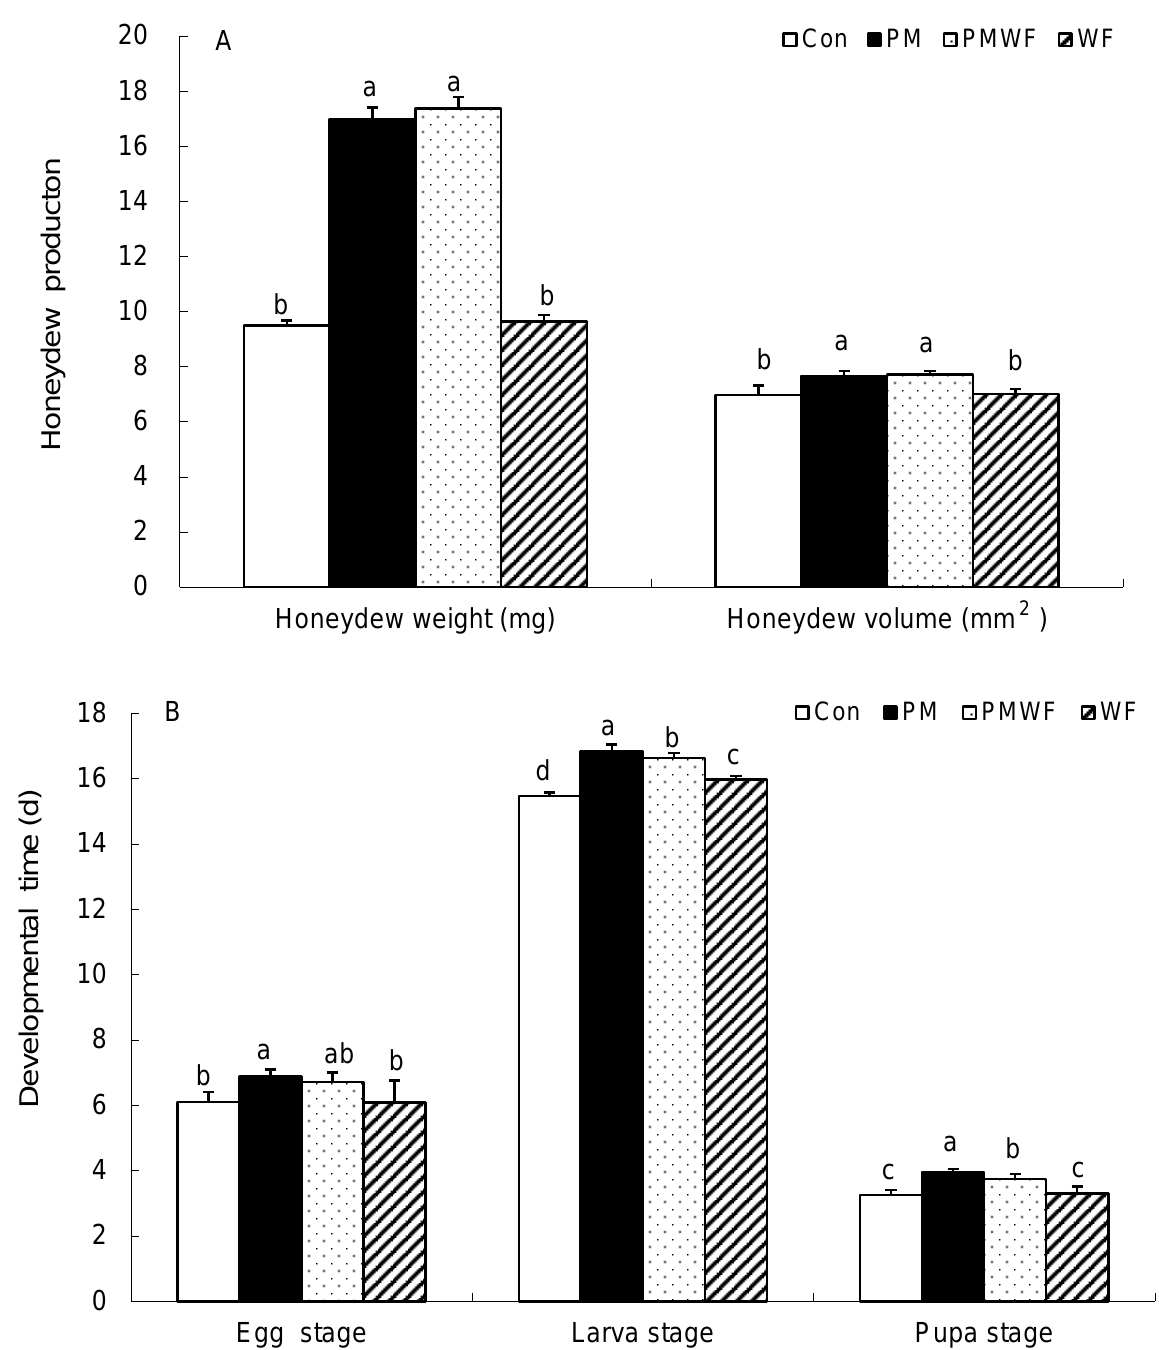
Figure 2. Effects of powdery mildew infections on the performance of T. vaporariorum : ( A ) honeydew production; ( B ) developmental time. There were six replicates for each treatment, n = 30 for each replicate of developmental time trial; n = 10 for each replicate of honeydew production trial. Bars (mean ± SD) followed by the same letters are not significantly different [ p > 0.05; post hoc Duncan’s multiple range test (DMRT) (SPSS Inc., 2000)].